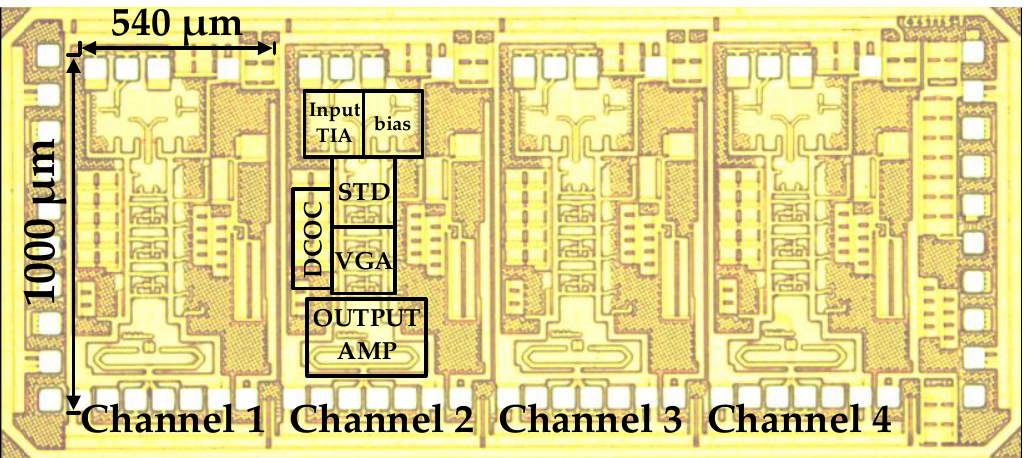
Figure 18. The microphotograph of the four-lane optical receiver.